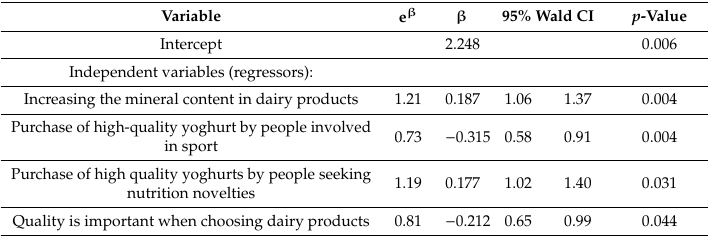
Table 8. Prediction of acceptance of adding health-promoting ingredients to livestock feed. Variable e β β 95% Wald CI p -Value Intercept 2.248